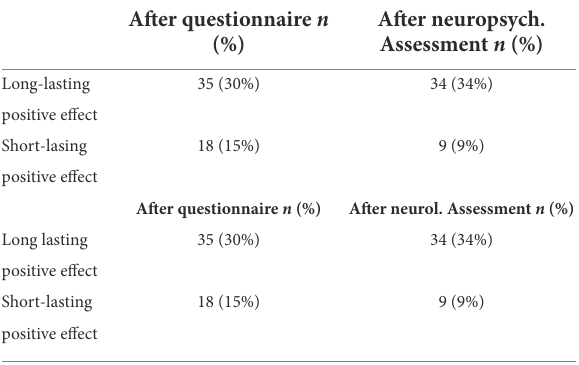
TABLE 2 Reported positive effects of